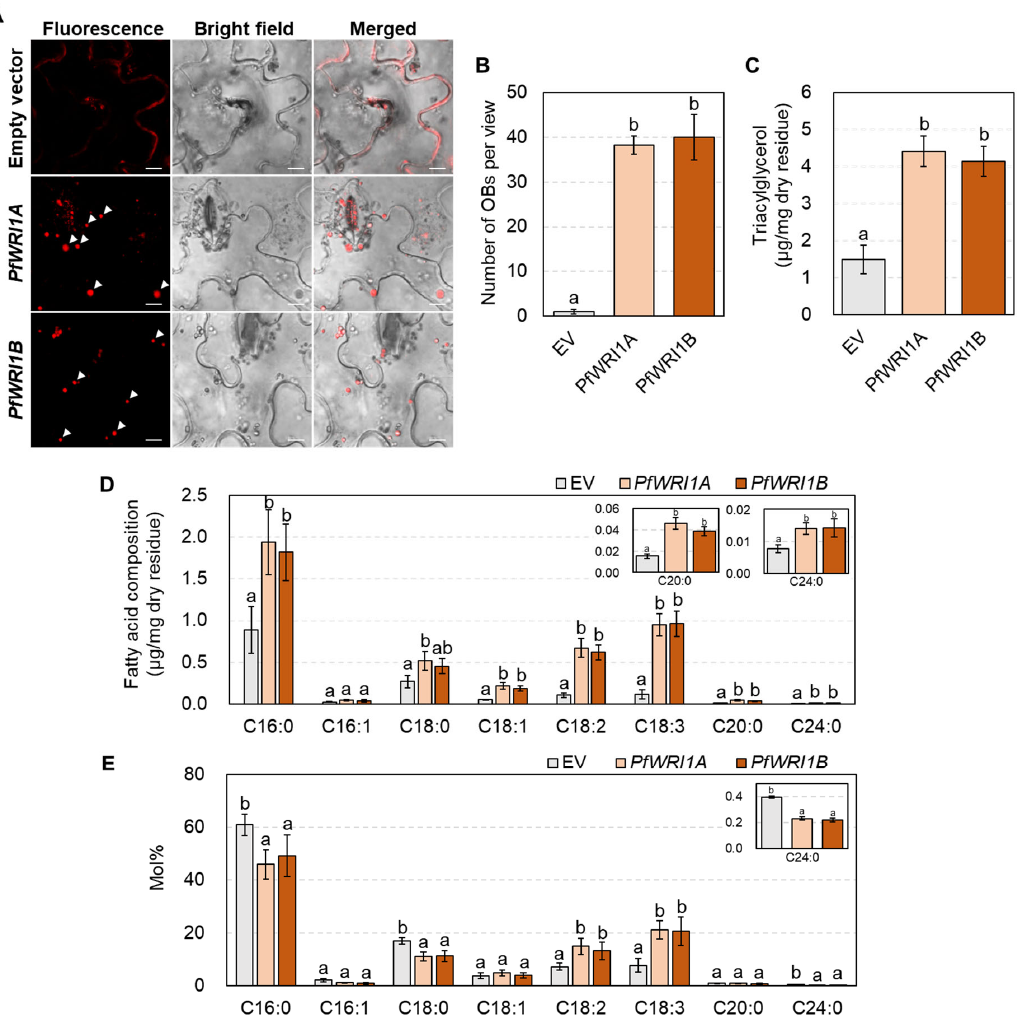
Figure 4. Oil body formation ( A ), oil body counts ( B ) and TAG accumulation ( C – E ) in N. benthamiana leaves expressing PfWRI1A:eYFP or PfWRI1B:eYFP . ( A ) Oil body formation in N. benthamiana leaves expressing PfWRI1A : eYFP or PfWRI1B : eYFP. Agrobacterium harboring the PfWRI1A:eYFP , PfWRI1B:eYFP , or empty vector without PfWRI1 construct was infiltrated into N. benthamiana leaves. The transformed N. benthamiana leaf disks were stained with Nile red solution and then the fluores ‐ cent signals were visualized under laser confocal scanning microscopy. The white arrows indicate oil bodies (OBs). Bars = 10 μ m. ( B ) Oil body (OB) counts in N. benthaminana leaves expressing empty vector ( pPZP212 ), PfWRI1A , or PfWIR1B . Values are averages and SD of four individual images. Data were statistically analyzed using ANOVA test ( p < 0.05). ( C – E ) Total TAG levels ( C ) and fatty acid levels ( D ) and composition ( E ) in the TAG fractions in N. benthamiana leaves expressing PfWRI1A:eYFP , PfWRI1B:eYFP , or empty vector. Total lipids were extracted from the transformed N. benthamiana leaf disks and fractionated by thin-layer chromatography. The TAG fractions were eluted, transmethylated, and then the fatty acid methyl esters were analyzed by gas chromatography. Values are averages and SD of four individual experiments. Data were statistically analyzed using ANOVA test ( p <